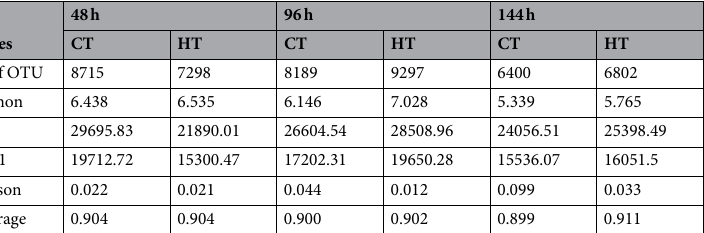
Table 3. Richness and diversity indexes in all samples. CT/HT was sample mentioned in Table 1. Chao1 and ACE indexes were used to estimate the total number of species in samples. Bacterial diversity was assessed with Shannon–Wiener diversity index and Simpson index, Shannon–Wiener diversity index positive correlation with microbial diversity, Simpson index negative correlation with microbial